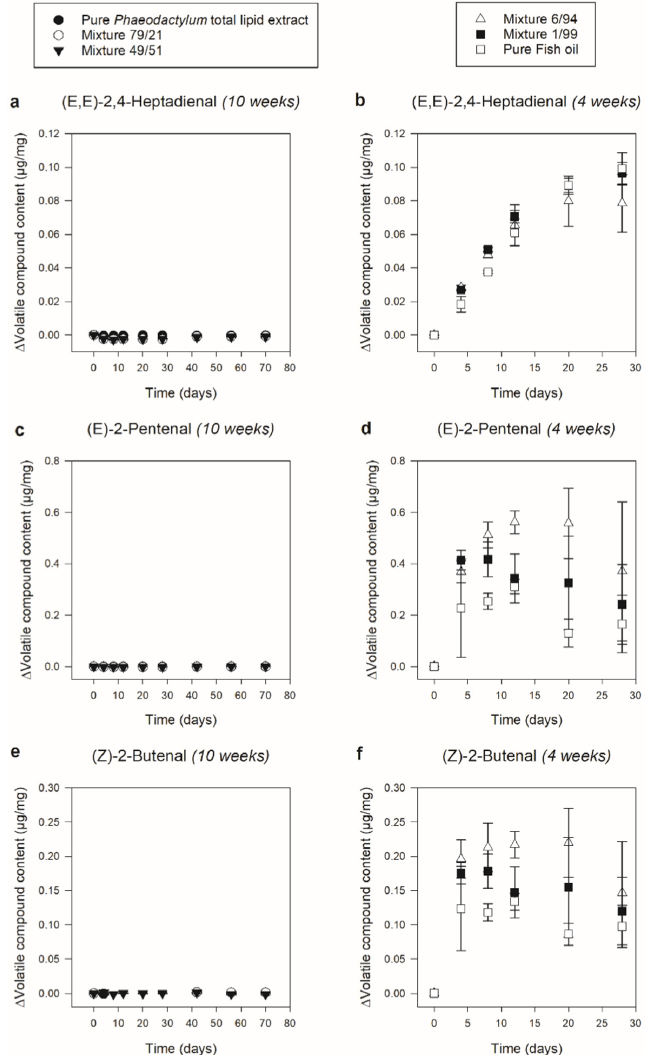
Figure 5. Secondary oxidation of six different ‘Phaeodactylum total lipid extract–fish oil’ systems during storage at 37 ◦ C. ‘Pure Phaeodactylum total lipid extract’, ‘Mixture 79/21’, and ‘Mixture 49/51’ (respectively possessing 100.0%, 78.6% and 49.2% ( w / w ) of Phaeodactylum total lipid extract) were stored for 10 weeks (left). ‘Mixture 6/94’, ‘Mixture 1/99’, and ‘Pure Fish oil’ (respectively possessing 6.4%, 0.7% and 0.0% ( w / w ) of Phaeodactylum total lipid extract) were stored for 4 weeks (right). The content of volatile compounds originating from lipid oxidation [(E,E)-2,4-Heptadienal ( a , b ), (E)-2-Pentenal ( c , d ), (Z)-2-Butenal ( e , f )] in µ g/mg (mean ± sd, n = 3) is expressed in delta values, representing the relative increase or decrease compared to day zero. Information on statistical significance can be found in Supplementary Materials (Table